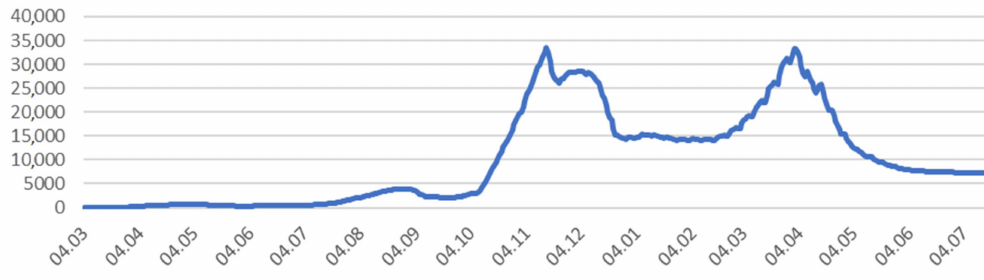
Figure 1. Number of active cases (COVID-19) in Małopolska. Source: Data collected on the basis of reports provided by the Ministry of Health, data from the WSEZ, PSSE, Voivodship Offices, and data obtained via requests for access to public